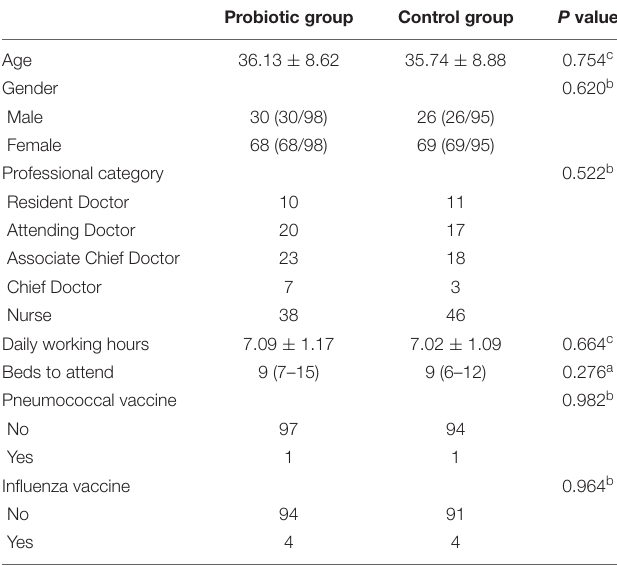
TABLE 1 | The baseline characteristics of